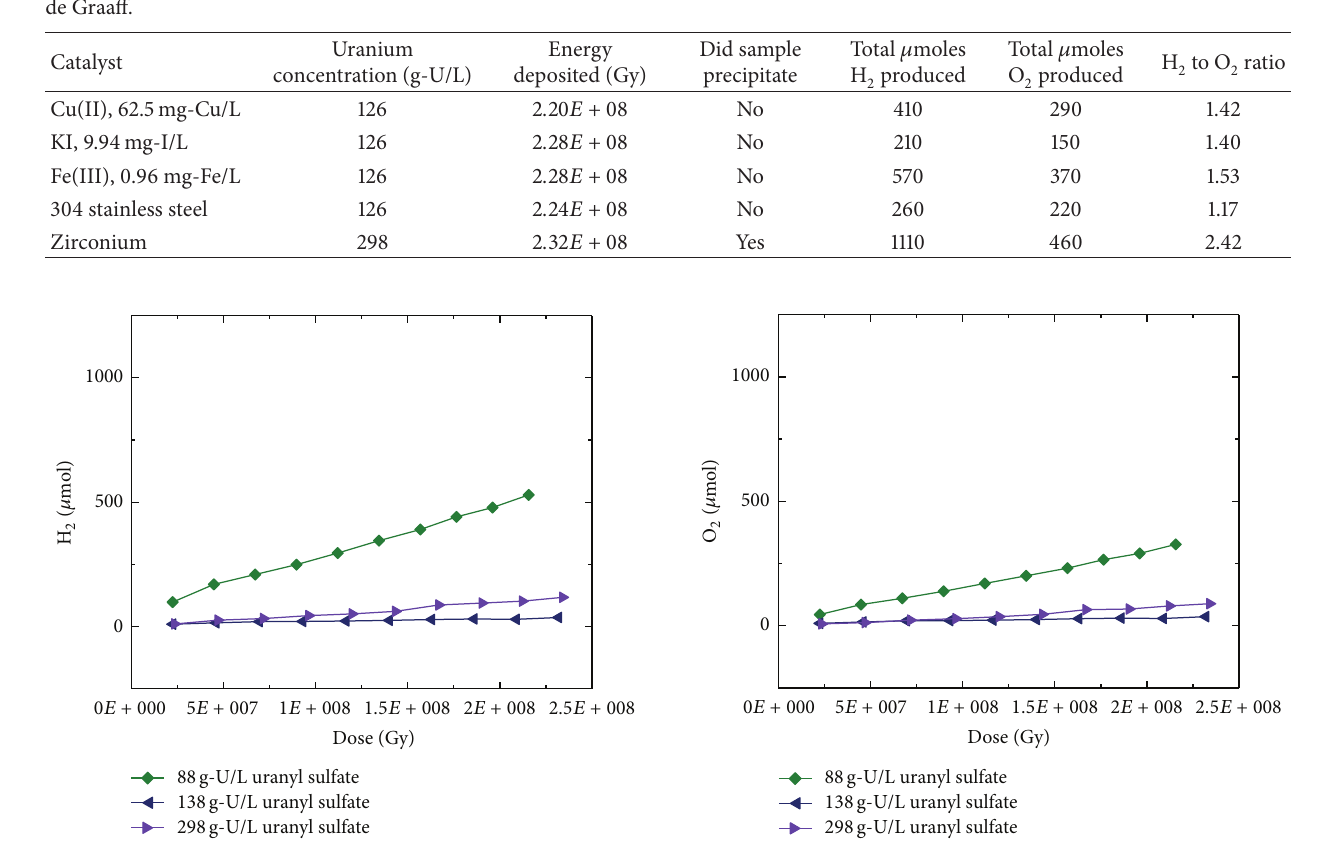
Figure 5: Hydrogen evolution measured during irradiation of UO 2 SO 4 solutions at the Van de Graaff.